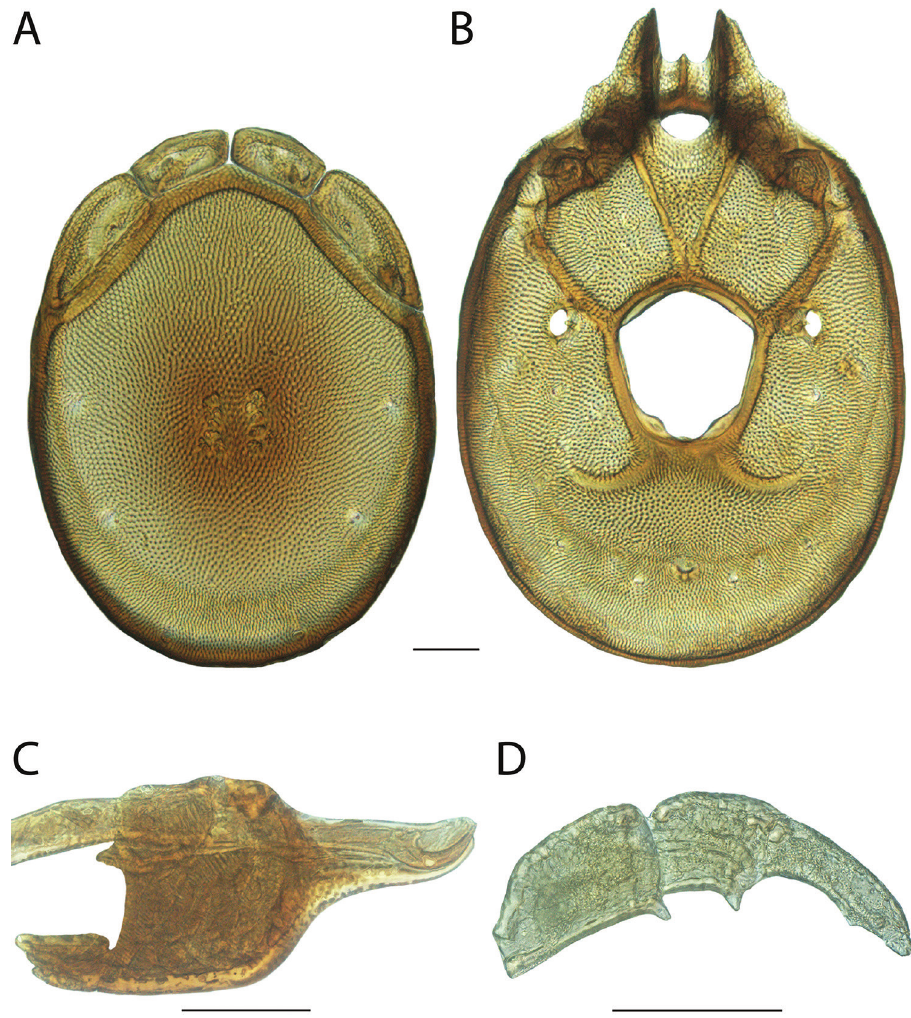
Figure 171. Torrenticola occidentalis female: A dorsal plates B venter (legs removed) C subcapitulum D pedipalp (setae not accurately depicted). Scale = 100 µm.